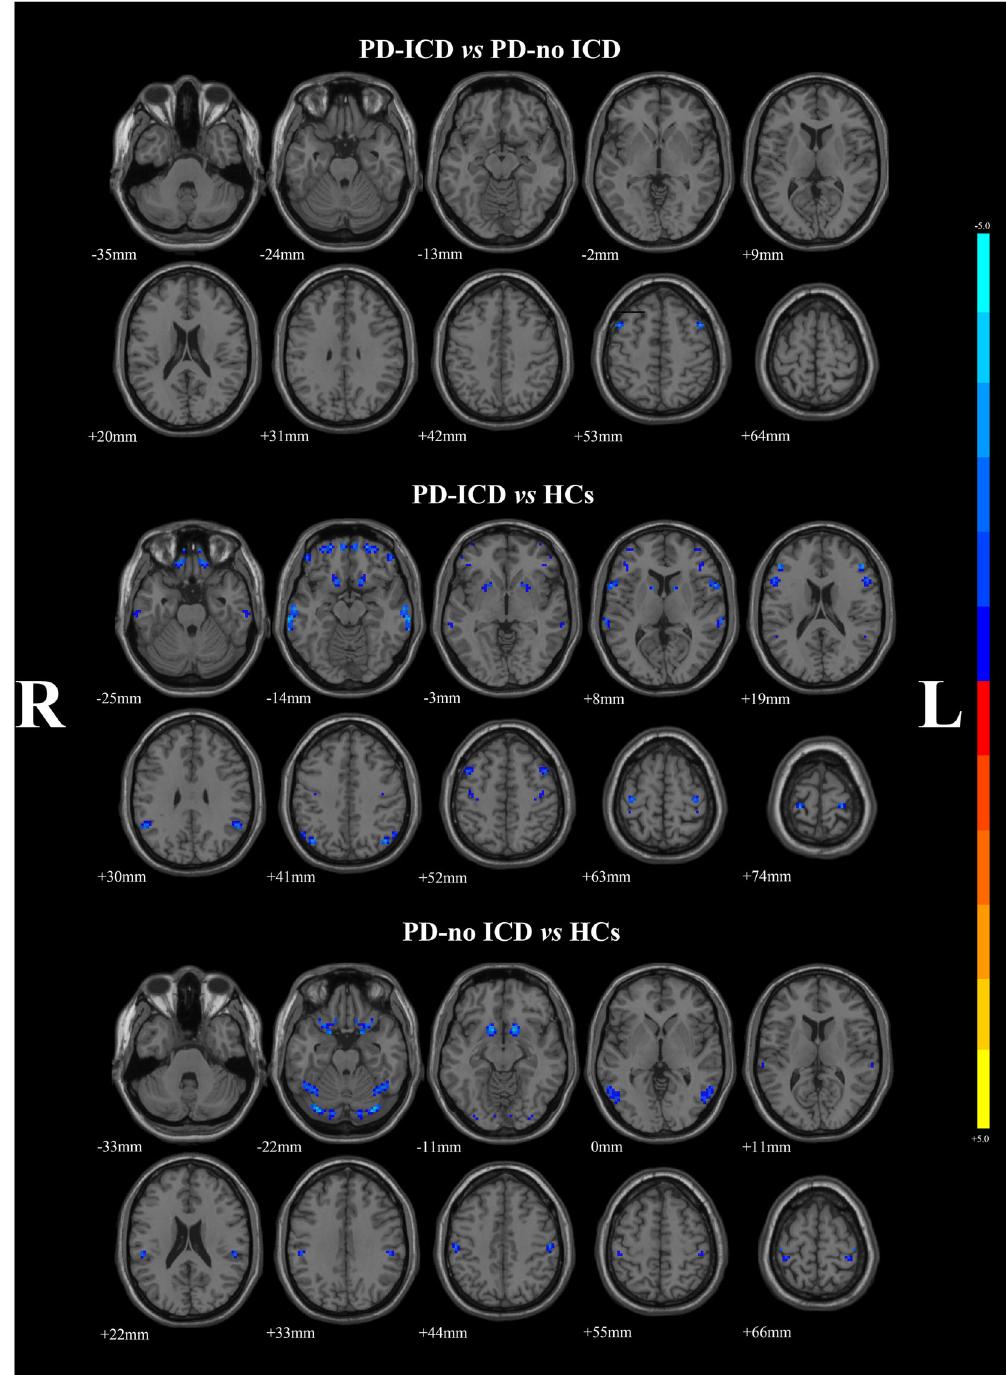
Fig. 1 Statistical maps showing VMHC differences in different brain regions among three groups. The threshold for display was set to p < 0.01. PD Parkinson ’ s Disease, VMHC voxel-mirrored homotopic connectivity, ICD Impulse control disorders, HCs health controls, R right, L